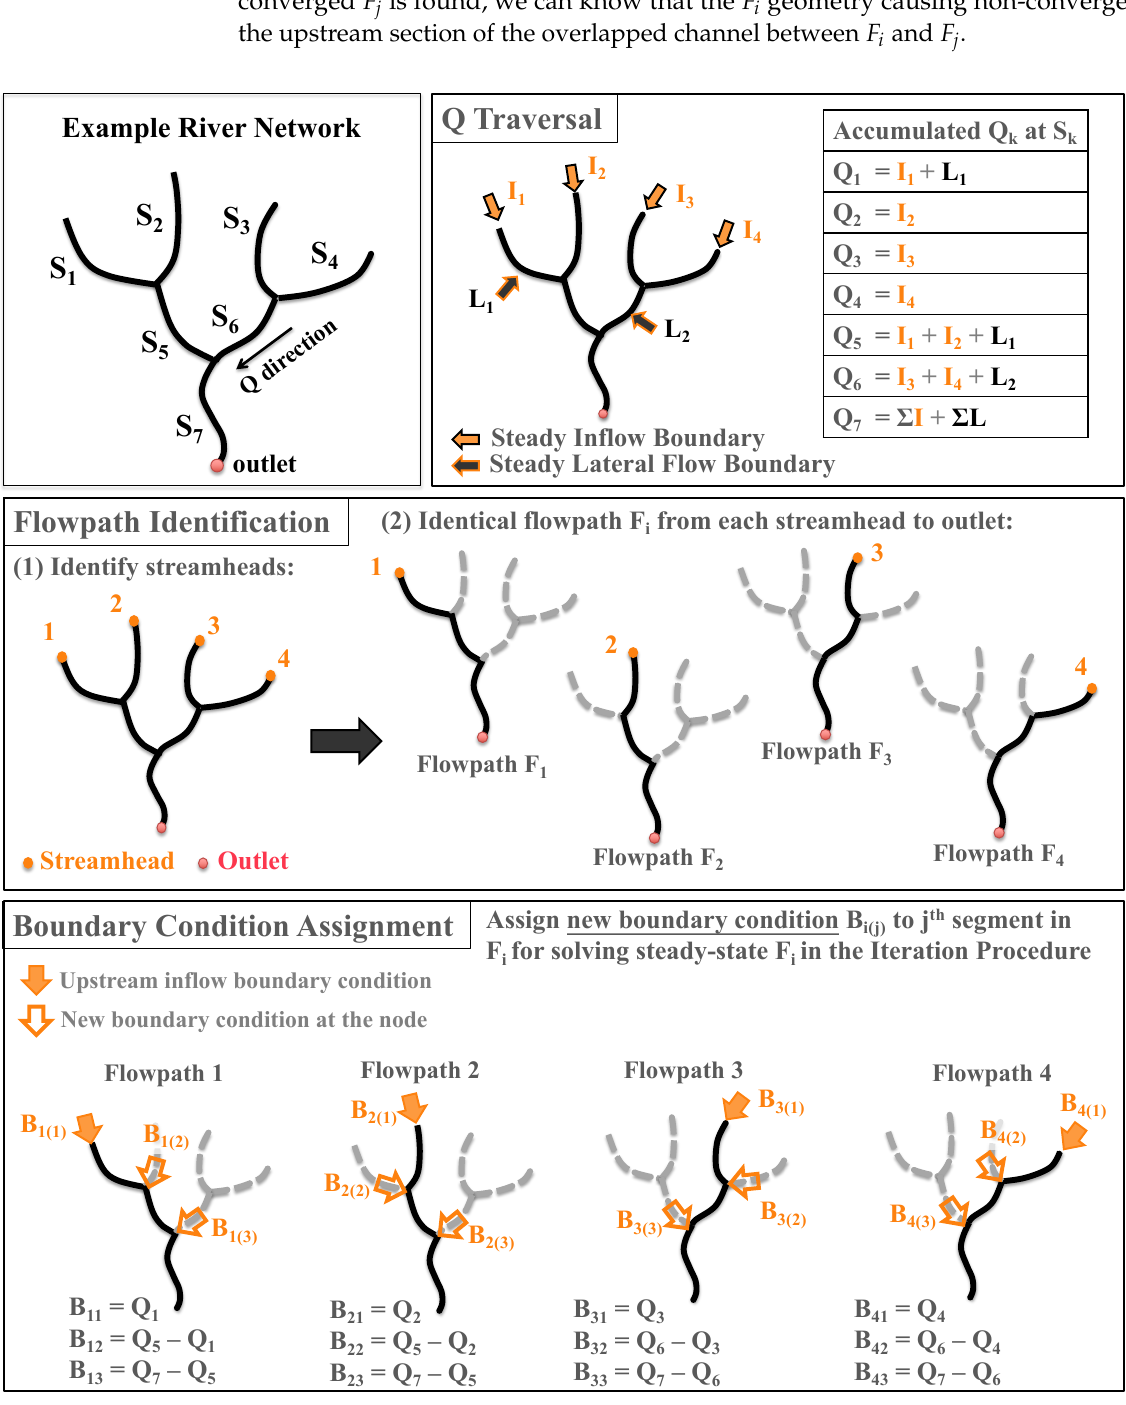
Figure 3. The three steps in the preprocess procedure: Q traversal, flowpath identification, and boundary condition assignment steps are illustrated with an example river network with 7 channel